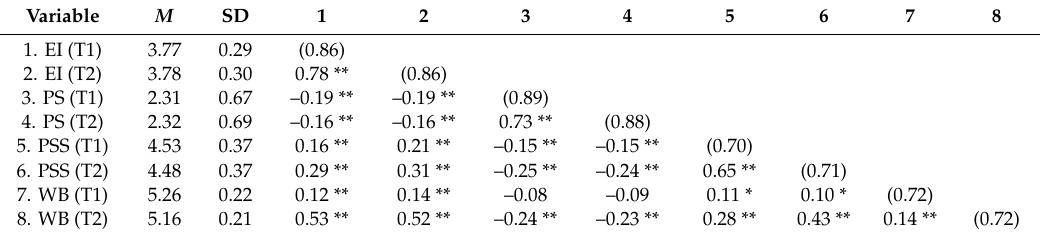
Table 1. Means, standard deviations, and correlations between the study